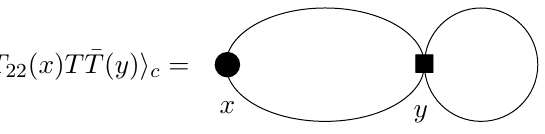
Figure 1 . Diagrammatic representation of h T 22 ( x ) T ¯ T ( y ) i c for free fields. The solid lines represent propagators of either free scalar field or Dirac fermion. Solid dot and square denote insertions of the stress tensor component T 22 and T ¯ T respectively. This correlation function is used to calculate h K T ¯ T i for free field